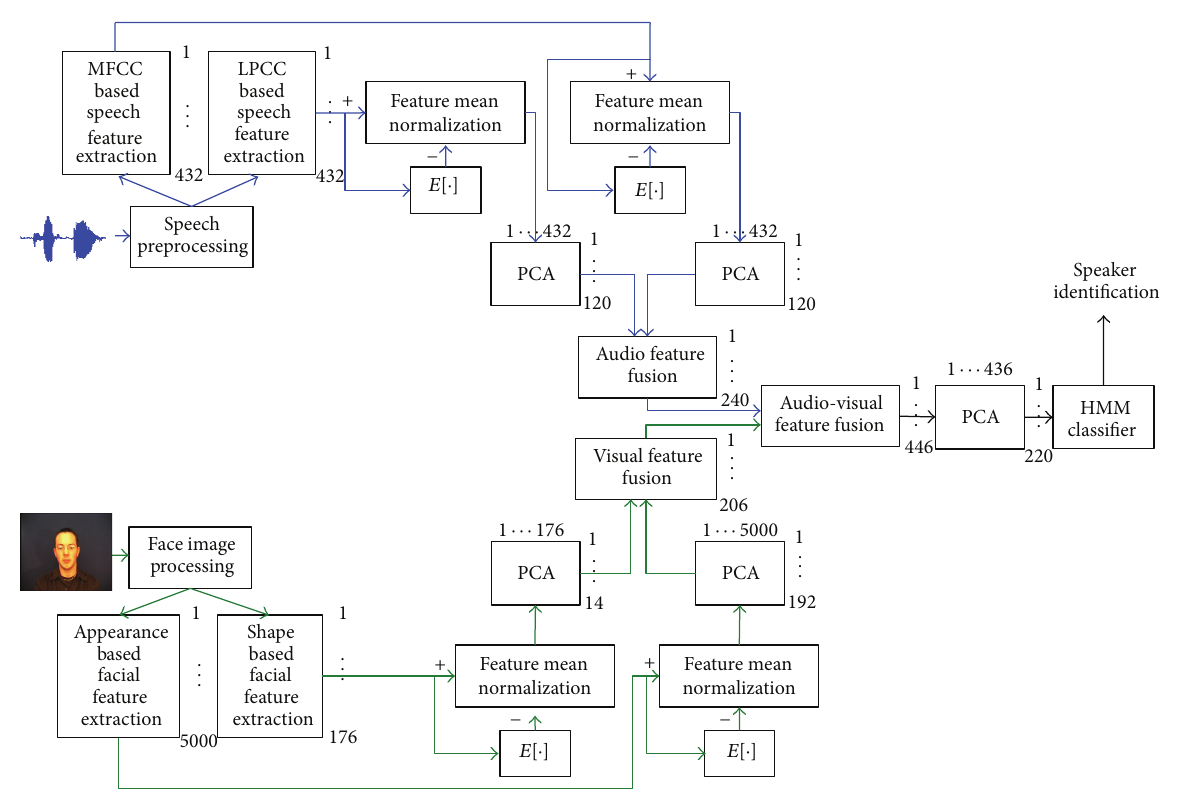
Figure 1: Paradigm of the proposed feature fusion based audio-visual speaker identification system.